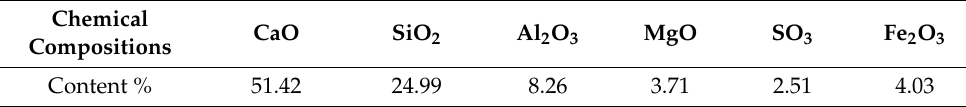
Table 3. Main compositions of PO42.5 ordinary Portland cement (%).